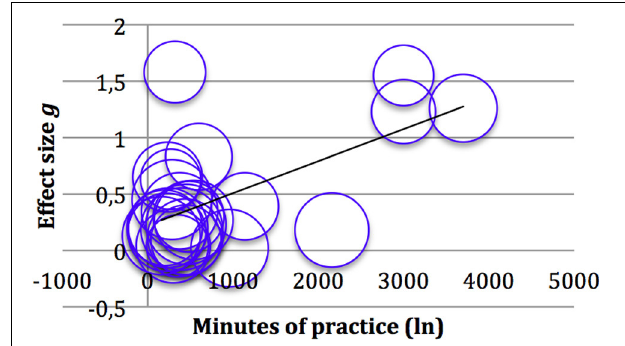
FIGURE 5 | Bubble plot of the 24 within group effects sizes against Intensity of mindfulness Training and regression line. R 2 (adjusted) = 0.21.